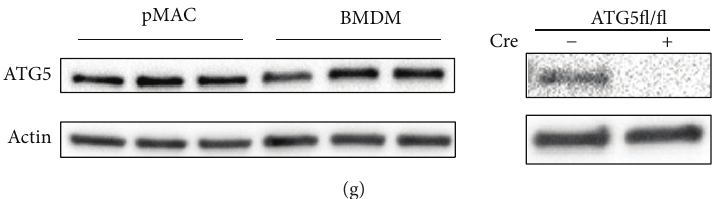
Figure 4: Differential role of the lysosome during activation of the lipotoxic inflammasome in pMACs compared to BMDMs. (a, b) pMACs (a) or BMDMs (b) were preloaded with the indicated doses of palmitate (palm) or with BSA for 2 h followed by BSA or palm ± 50ng/mL LPS for 20 h after which IL-1 𝛽 in the supernatant was quantified by ELISA. (c, d) pMACs (c) or BMDMs (d) were stimulated with palmitate and LPS in the presence of bafilomycin (BAF, 25 nM) or CAO74-ME (10 𝜇 M) and IL-1 𝛽 release at 20 h was determined by ELISA. (e, f) pMACs (e) or BMDMs (f) were prepared from WT (white bars) or ATG5KO (black bars; ATG5fl/fl X LysM-Cre) mice and were subsequently stimulated with BSA-PBS, BSA-LPS, or palm-LPS for 20 h. IL-1 𝛽 release was quantified by ELISA. The inset in (e) shows data for BSA-PBS versus BSA- LPS with an adjusted scale. (g) Total cellular protein was isolated from pMACs or BMDMs and expression of ATG5 was determined by western blotting ( left panel ). As a control for the antibody, protein was also isolated from WT and ATG5KO pMACs and analyzed by western blot ( right panel ). Bar graphs report the mean ± standard error (SE) for a minimum of 3 experiments, each performed in triplicate. ∗ 𝑃 < 0.05 for BSA-PBS versus palm-LPS; vehicle versus inhibitor; or WT versus